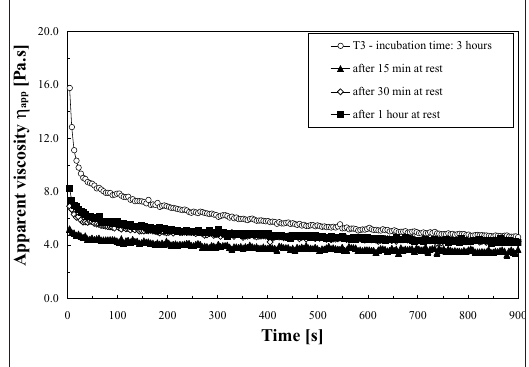
Figure 4: Representative plots of structure recovery in time (T2 and T3 yoghurt